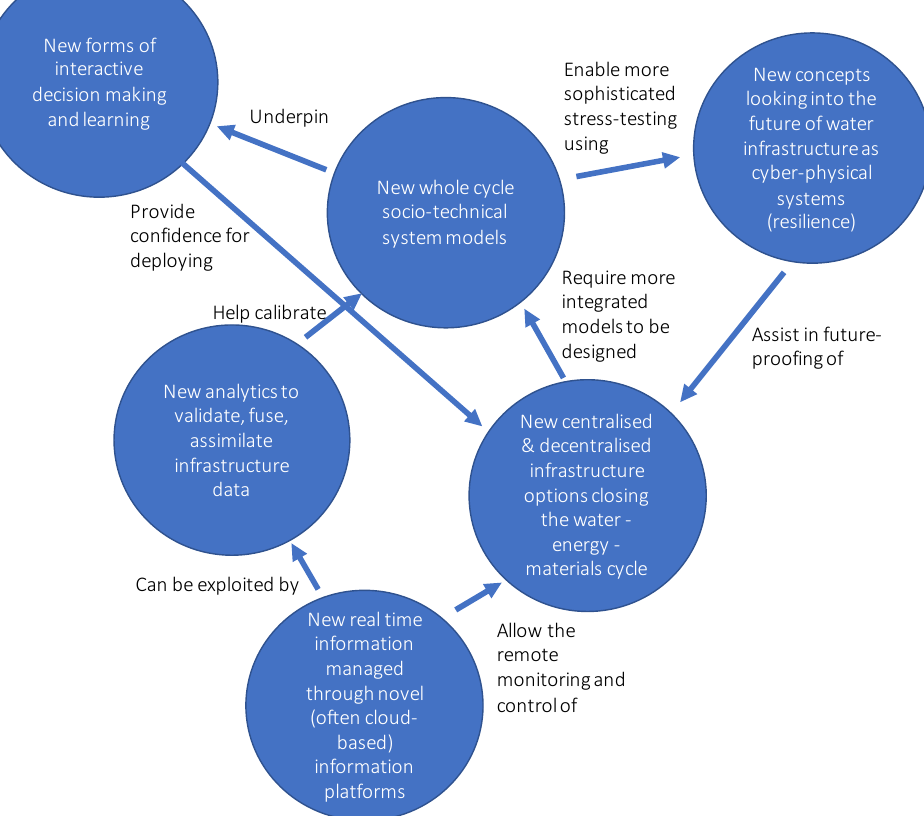
Figure 2. A shifting landscape for hydroinformatics research and practice .